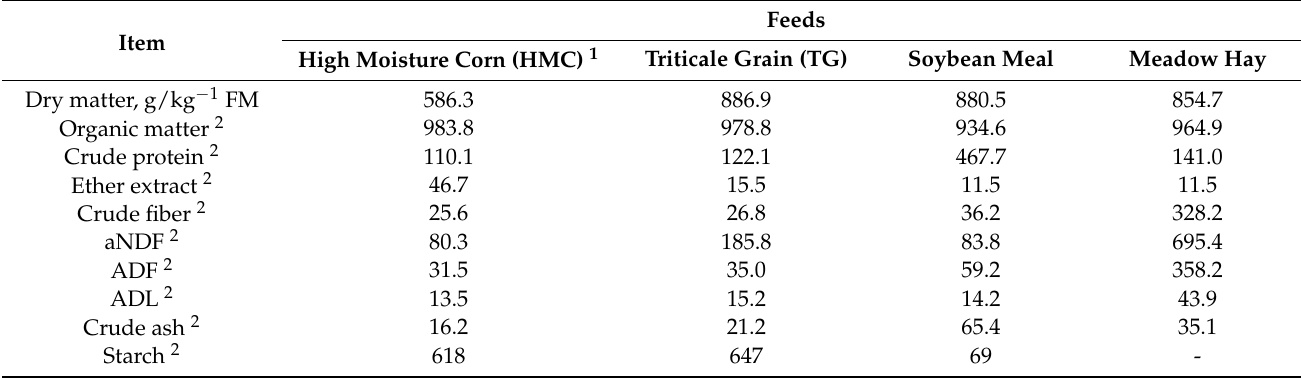
Table 1. Chemical composition of